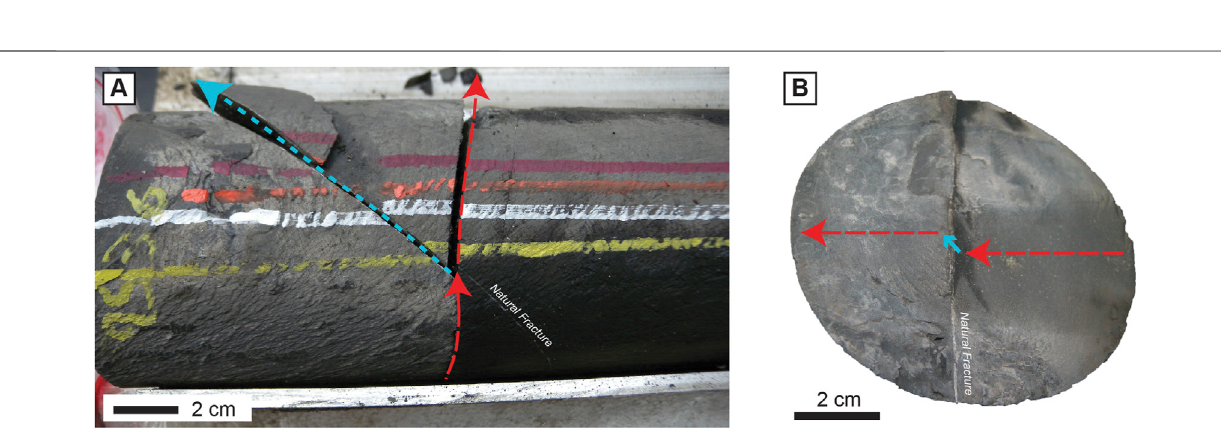
Frontiers in Earth Science |